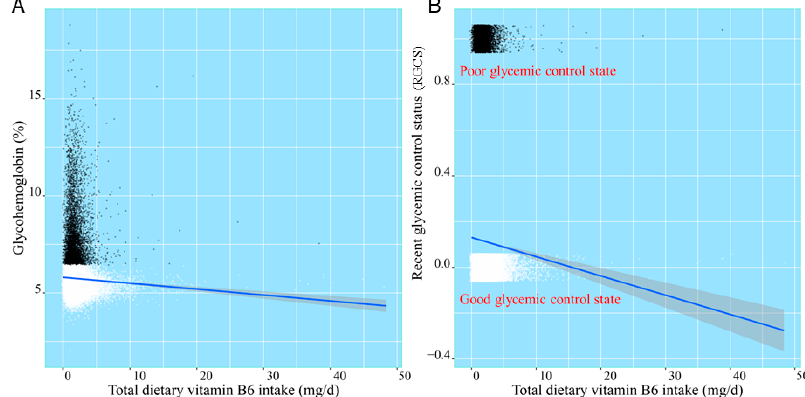
Figure 3. The model fitting processes of non-linear regression curve (( A , B ), scatter plots; ( C ), the optimal smooth curve).